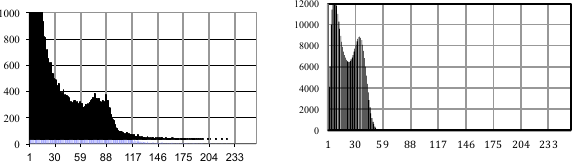
Figure 4 - Histogram of the difference image, which reflects only the brightness change - Visual assessment as a result of the analysis of the difference histogram; - Statistical evaluation of the minimum average risk for the normal approximation of the background component and